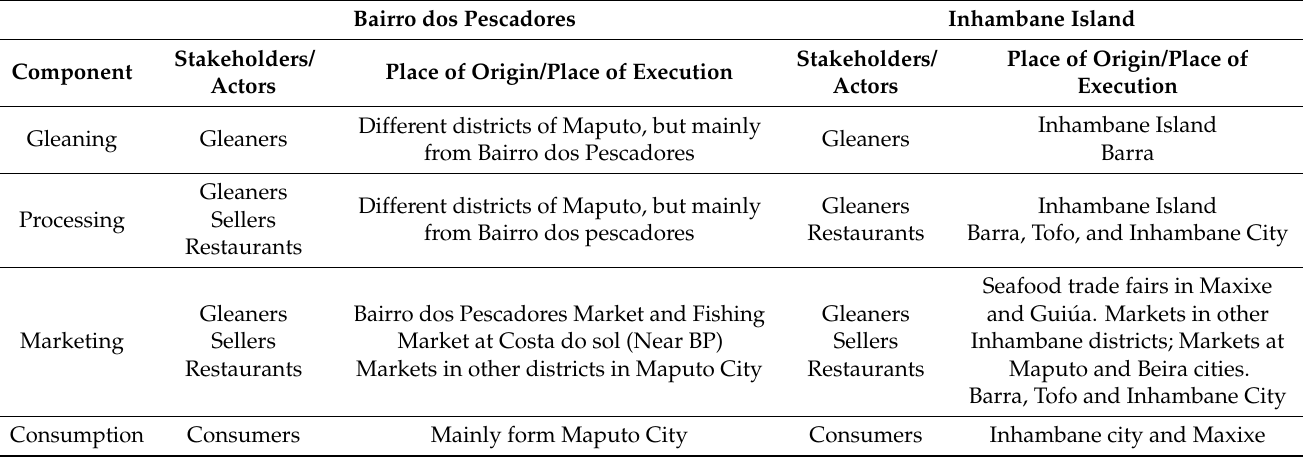
Table 6. Value chain components at each site, and